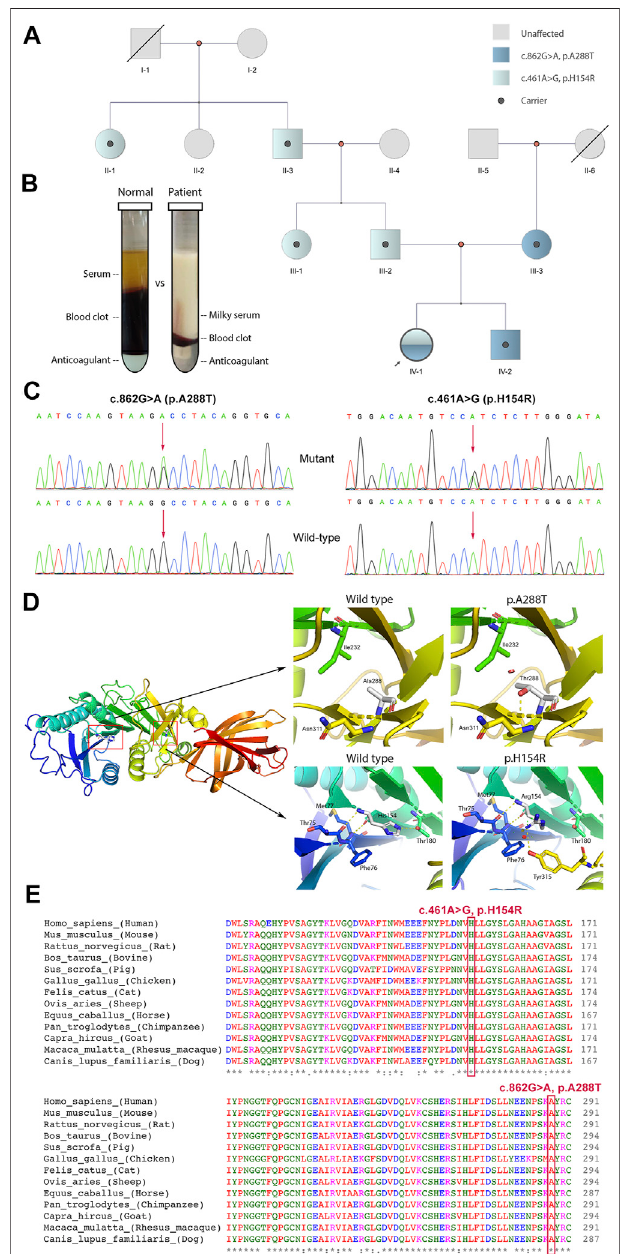
FIGURE 1 | Clinical and genetic information of the patient. (A) Pedigree analysis of this family. (B) Blood fractionations (set for 24 h) between control and the patient. (C) Sanger sequencing of variants c.862G > A and c.461A > G with corresponding wild-types. (D) Three-dimensional protein model of lipoprotein lipase. Polar contacts (yellow dash line) between His154 and Arg180 lost and new interactions between His154 and Tyr315 appeared after H154R alteration. With A288T variant, a new repulsion formed between Thr288 and Ile232 (red cylinder). (E) Multiple alignments of LPL protein sequence across 13 species. Mutation sites His154 and Ala288 are labelled by a red rectangular. *in the last row indicates amino acid in this site is “ highly conserved ” .